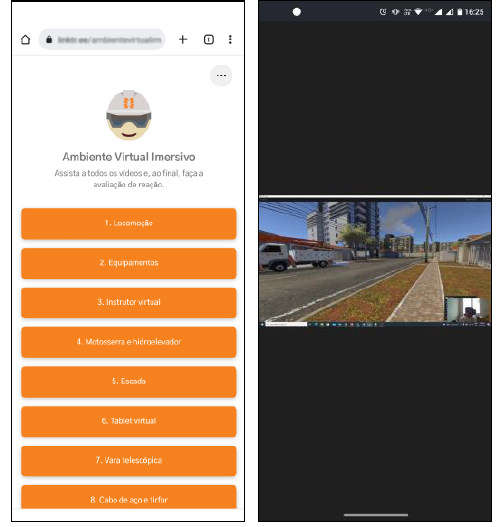
Figure 16. Screenshots of the tutorial videos provided.